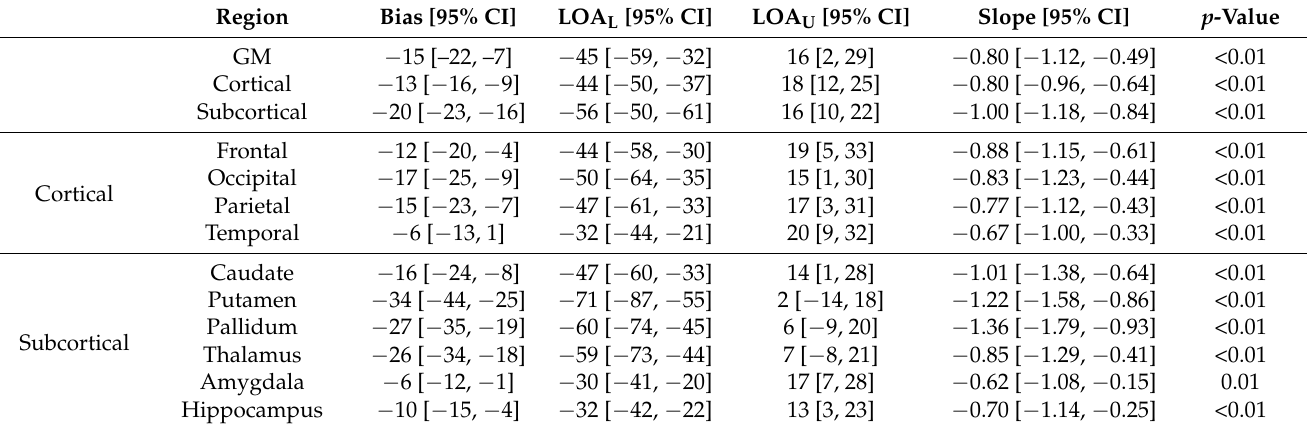
Table 2. Bland–Altman analysis with slope from the linear regression of the difference between CBF ASL and CBF PET on the average of CBF ASL and CBF PET .